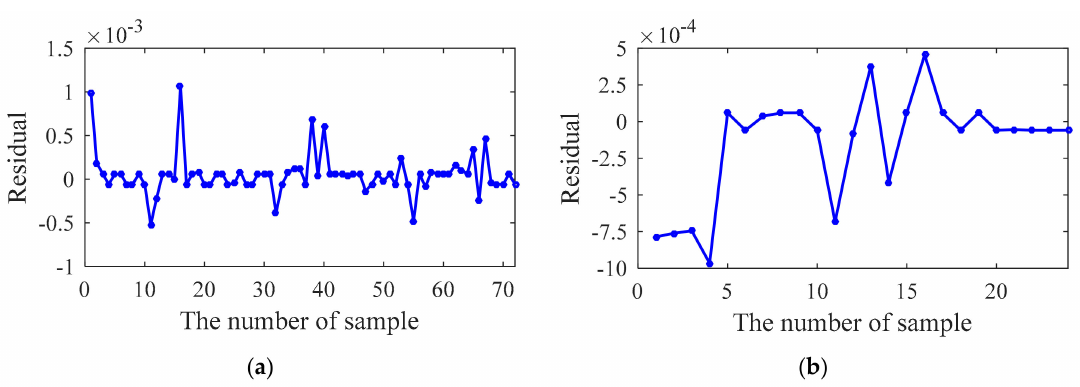
Figure 14. Residual of the first modal frequency: ( a ) Training sample; ( b ) Testing sample.